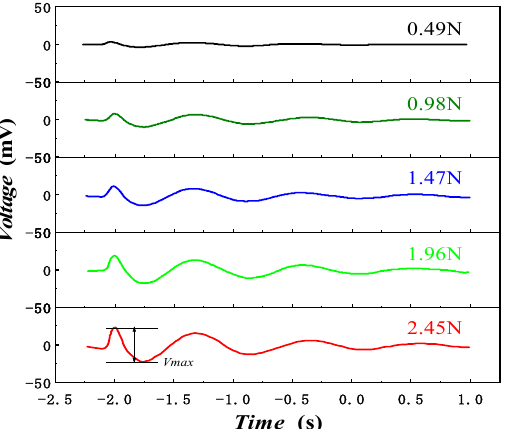
Figure 13. Output voltage response curve of piezoelectric film sensor.